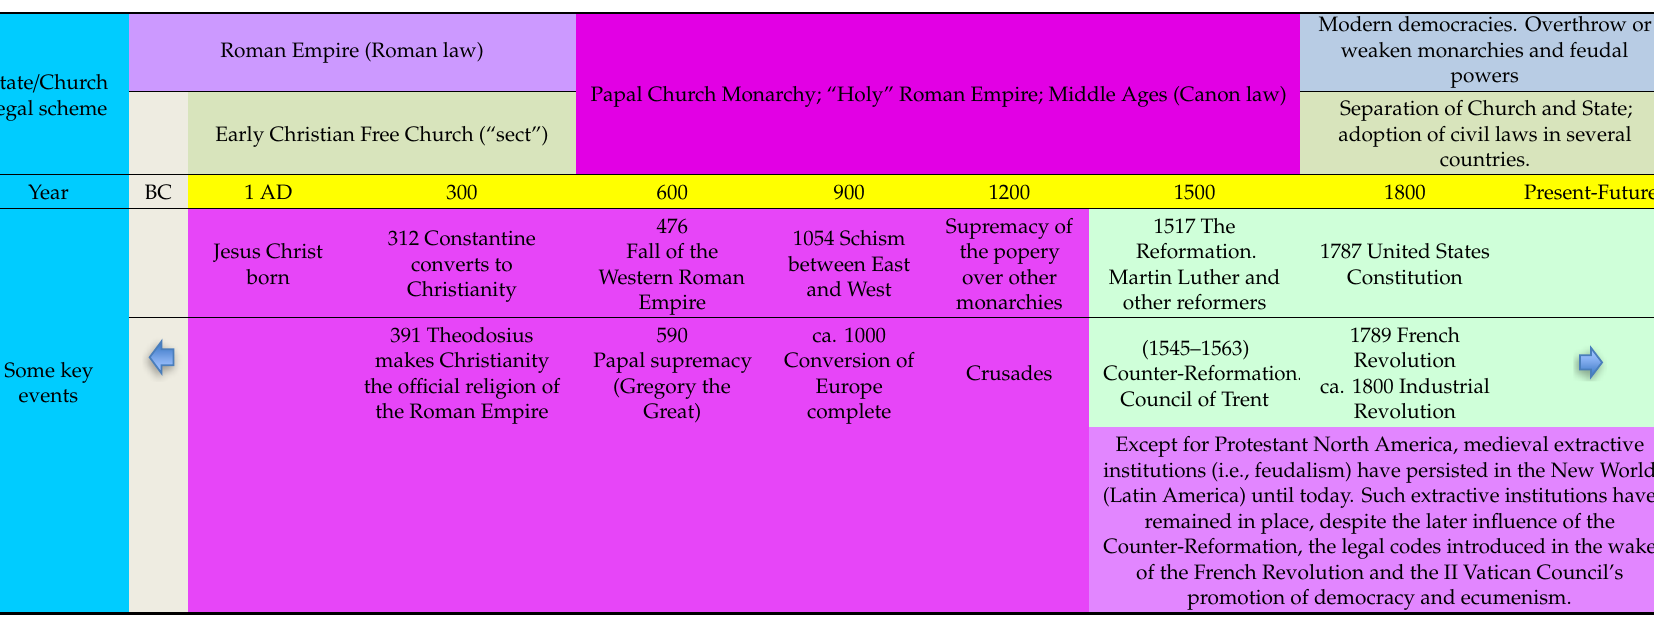
Table 1. Historical timeline of some key religio-political events in Christendom (Source: Author’s chart; based on the theoretical framework of this study). Among others, sources include Woodberry (2012), Miller (2012), Acemoglu et al. (2011), Snyder (2011), Bruce (2007), Berman (2003), Witte (2002), Heussi (1991), D’Aubigne (1862), and Eusebius of Caesarea. ca. 340 AD (Eusebius of Caesarea. ca. 340